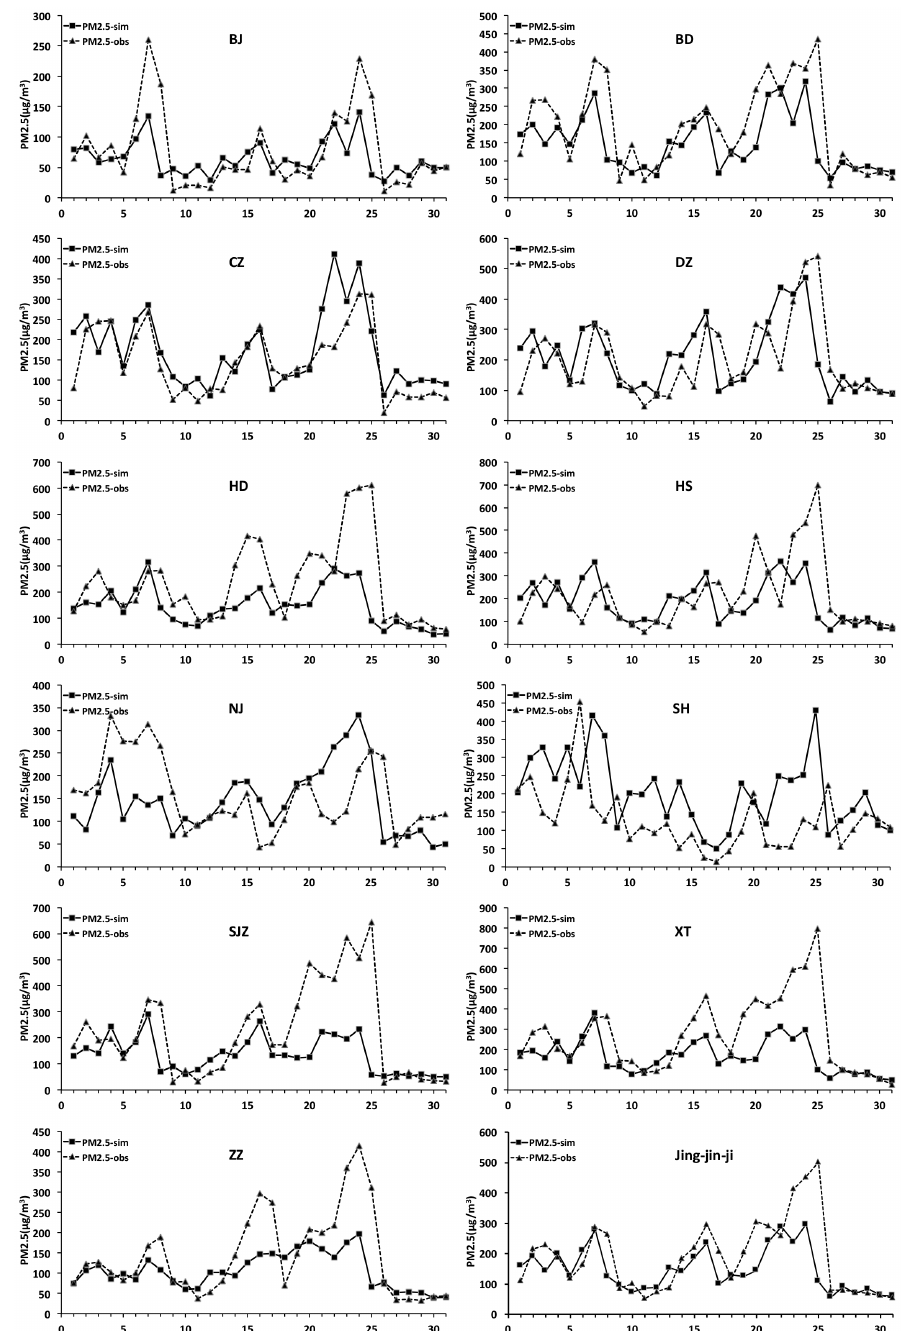
Figure 4. Daily variations in observed and simulated PM 2 . 5 (µgm − 3 ) for 1–31 December 2013 at stations in BJ, BD, CZ, DZ, HD, HS, NJ, SH, SJZ, XT, ZZ and the whole